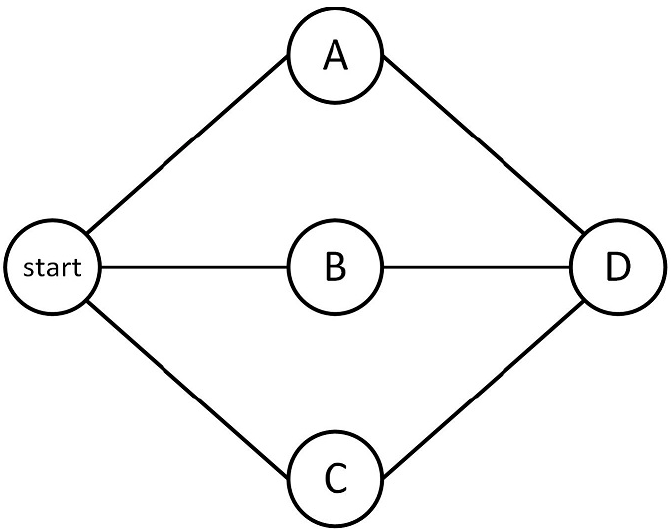
Figure 9. Example graph to illustrate computation of Edges ( node D )